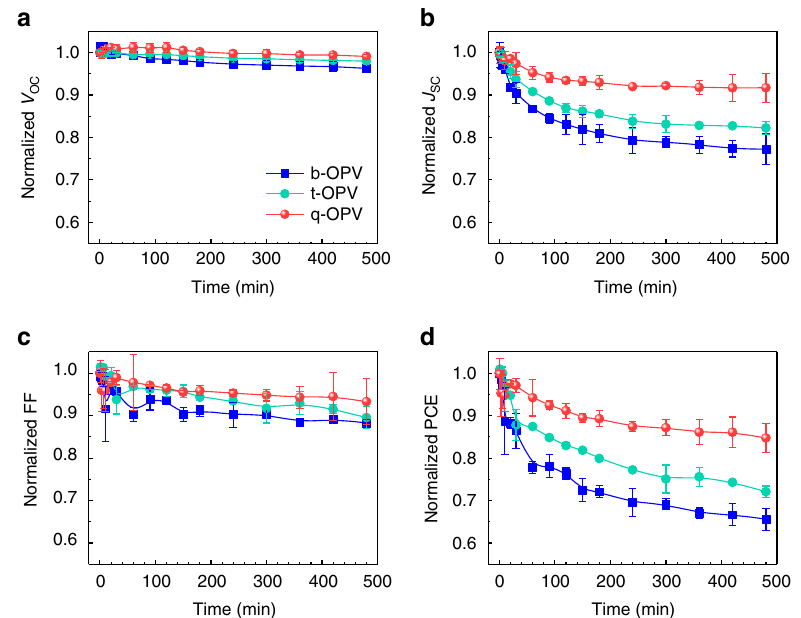
Figure 3 | Suppressed initial photovoltaic performance loss in the q-OPV. ( a ) V OC , ( b ) J SC , ( c ) FF and ( d ) PCE as a function of thermal treatment time (up to 8h) at 65 (cid:2) C for b-, t- and q-OPVs. The mean values with s.d. were obtained from more than 12 cells.